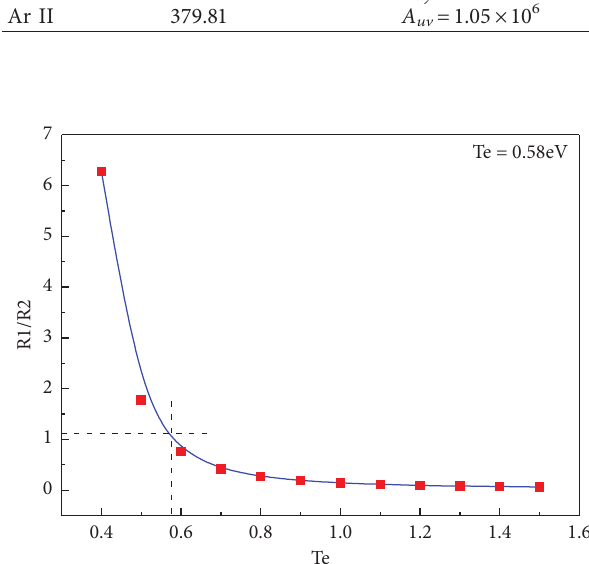
Figure 6: Graph of intensity ratio of the corresponding wave- lengths as a function of electron temperature at 5 kV and an op- erating frequency of 19.56kHz (argon flow rate 5